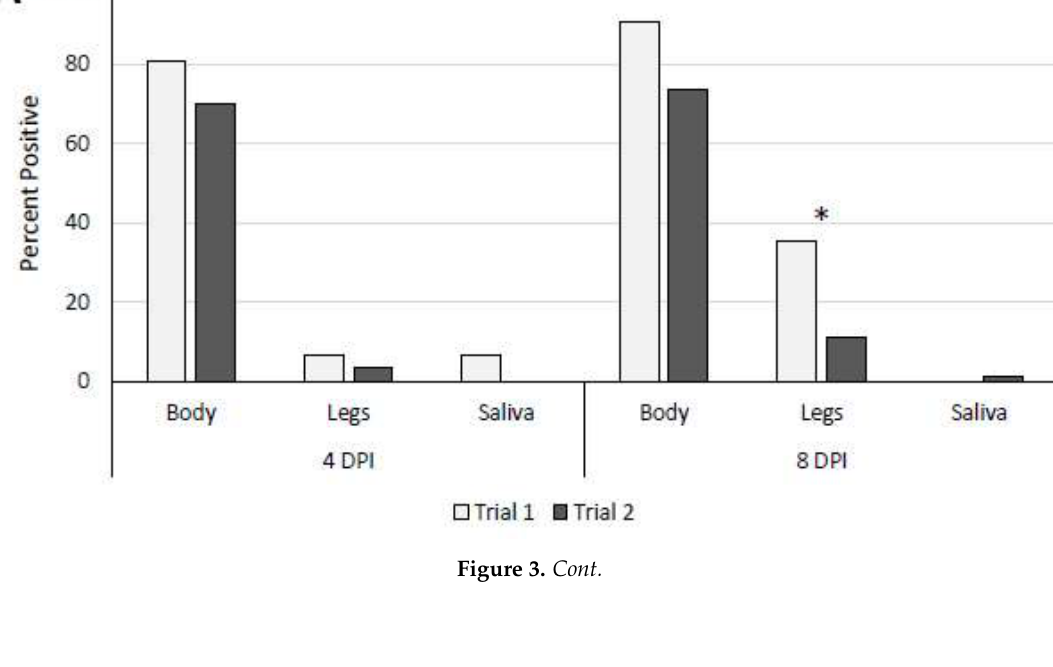
Figure 3. Comparison of Culex quinquefasciatus outcomes when exposed to DTRs of 11 °C (Trial 1) and 15 °C (Trial 2). ( A ) Overall percent positive bodies (infection), legs (dissemination), and saliva (transmission potential); Significance at p = 0.05 is denoted with *. ( B ) Box plots showing comparative body and leg titers at 4 DPI (on left) and 8 DPI (on right).